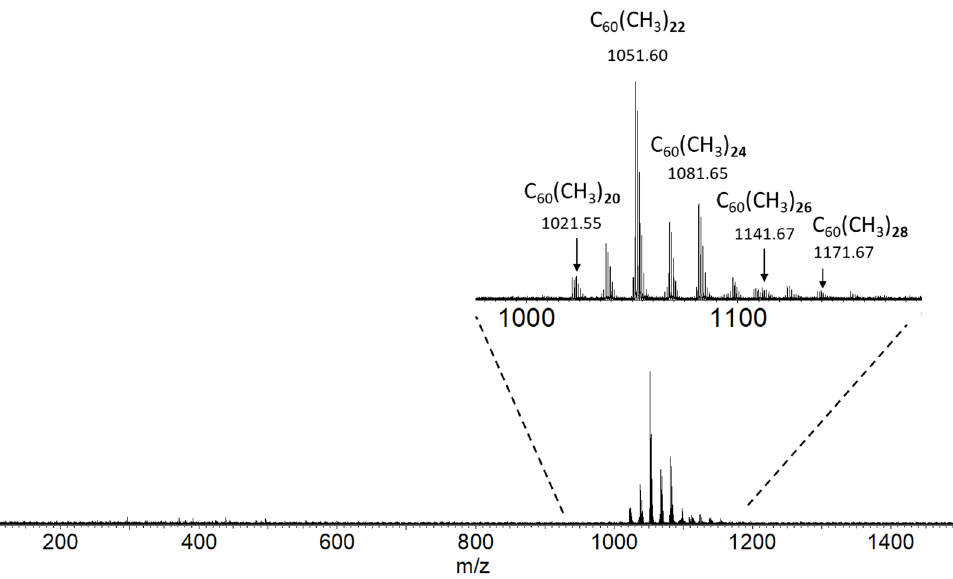
Figure 8. DART-MS (positive) spectrum of the obtained mixture of C 60 (CH 3 ) n .